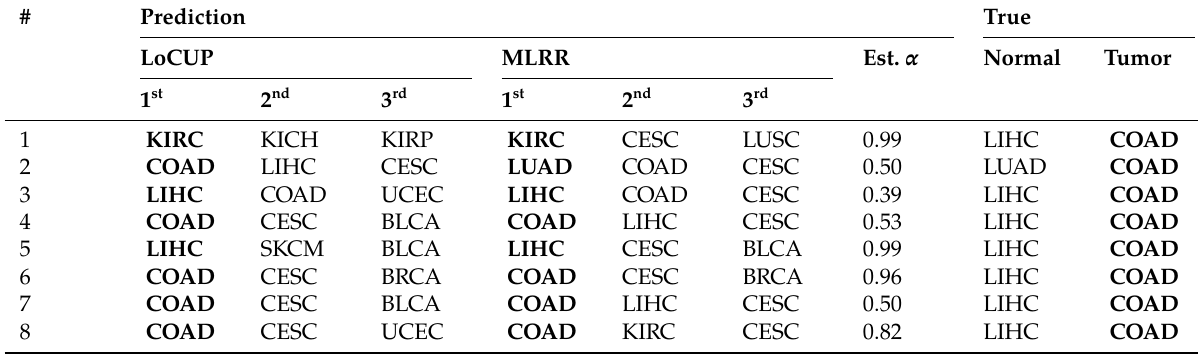
Table 2: Prediction on dataset of real metastatic samples with known primary tumor